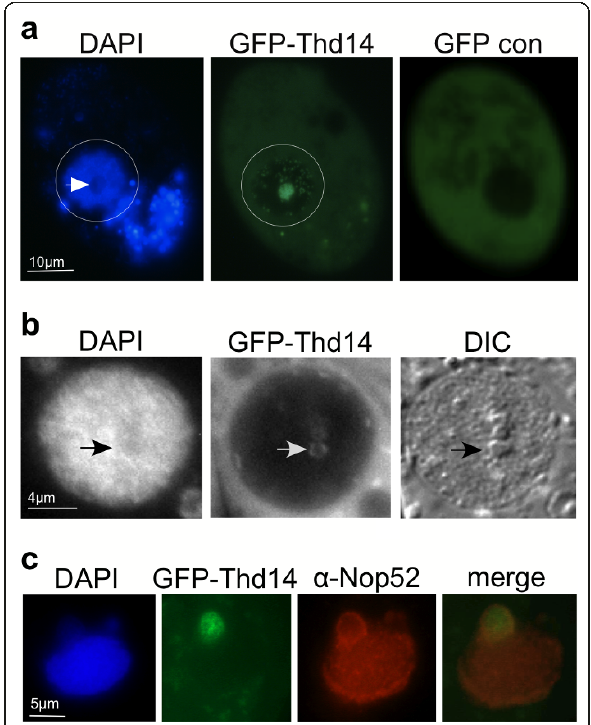
Figure 7 Thd14 resides in a large aggregate during starvation . a A starved live cell expressing GFP-Thd14 visualized by fluorescence microscopy. The macronucleus is within the circled regions. Staining outside the nucleus is in food vacuoles. White arrow points to a DAPI poor region where GFP-Thd14 aggregates. “ GFP con ” is the negative control expressing only GFP (no fusion with Thd14). b DAPI, GFP and DIC images of a macronucleus in a live cell. Masses inside the macronucleus observed by DIC microscopy (arrow) are ringed by GFP-Thd14 and stain weakly with DAPI, both observed by fluorescence imaging. c A macronucleus showing Nop52 ringing around the large aggregate of GFP-Thd14 by